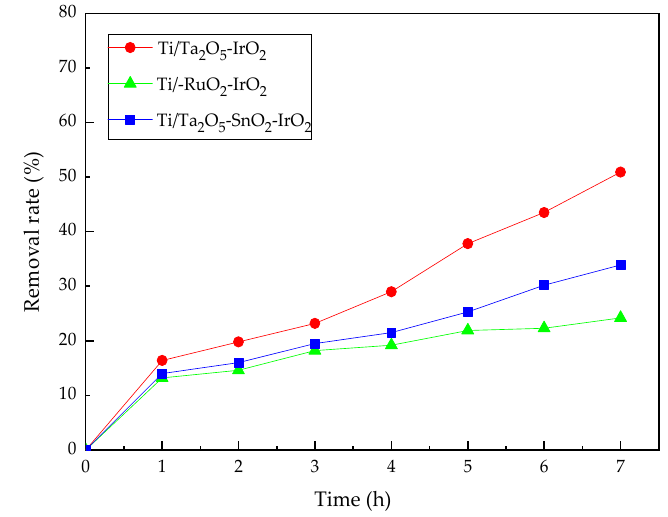
Figure 5. Effect of different electrodes on the degradation of nicosulfuron.